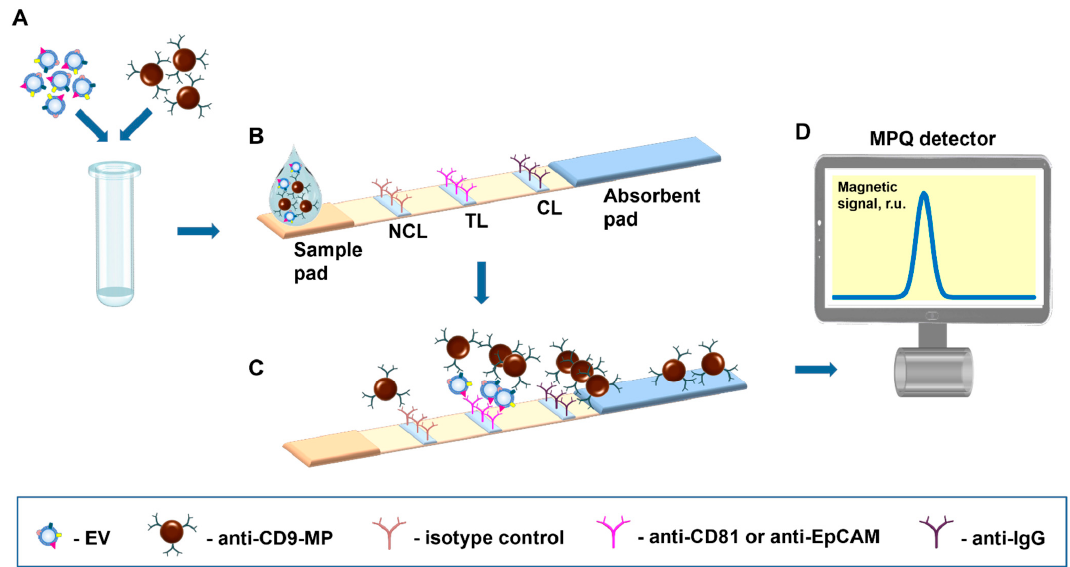
Figure 1. Scheme of the nanomagnetic IC tool for EV quantification. ( A ) Samples are incubated with magnetic nanoparticles functionalized with an EV-specific antibody. ( B ) Test strip design. ( C ) Im- munochemical reactions during the migration along the test strip of the sample containing EVs– anti-CD9-MP complexes. ( D ) The test strip is inserted into an MPQ detector to register magnetic signals from the